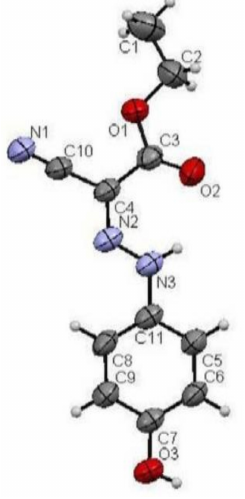
Figure 3. ORTEP of dye 4